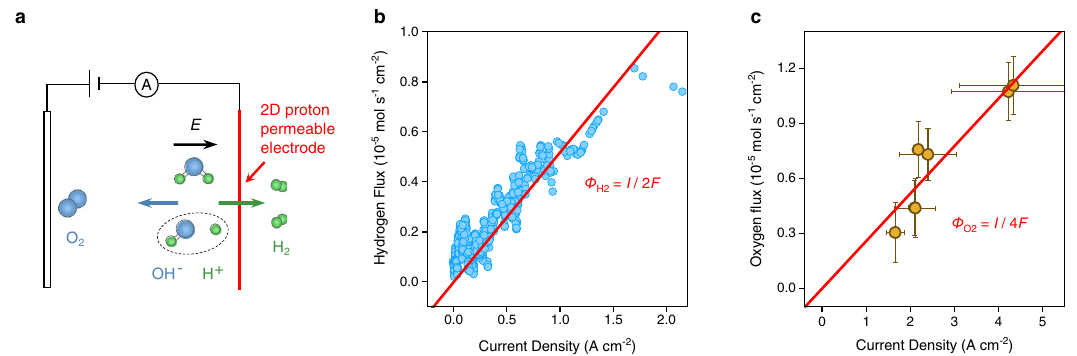
Fig. 3 | Faradaic ef fi ciency measurements of H 2 and O 2 . a Schematic of experi- mentalsetup. b Hydrogen fl ux Φ H2 asafunctionofcurrentdensity I measuredwith a mass spectrometer (Supplementary Fig. 4). Solid red line marks the Faraday law I /2 F , where F is the Faraday constant. c Oxygen fl ux Φ Φ H2 = fi eld-dependent conductance is given by: G with G H (0) ≈ 0.1mS cm − 2 the proton conductivity at pH 7. Figure 2c